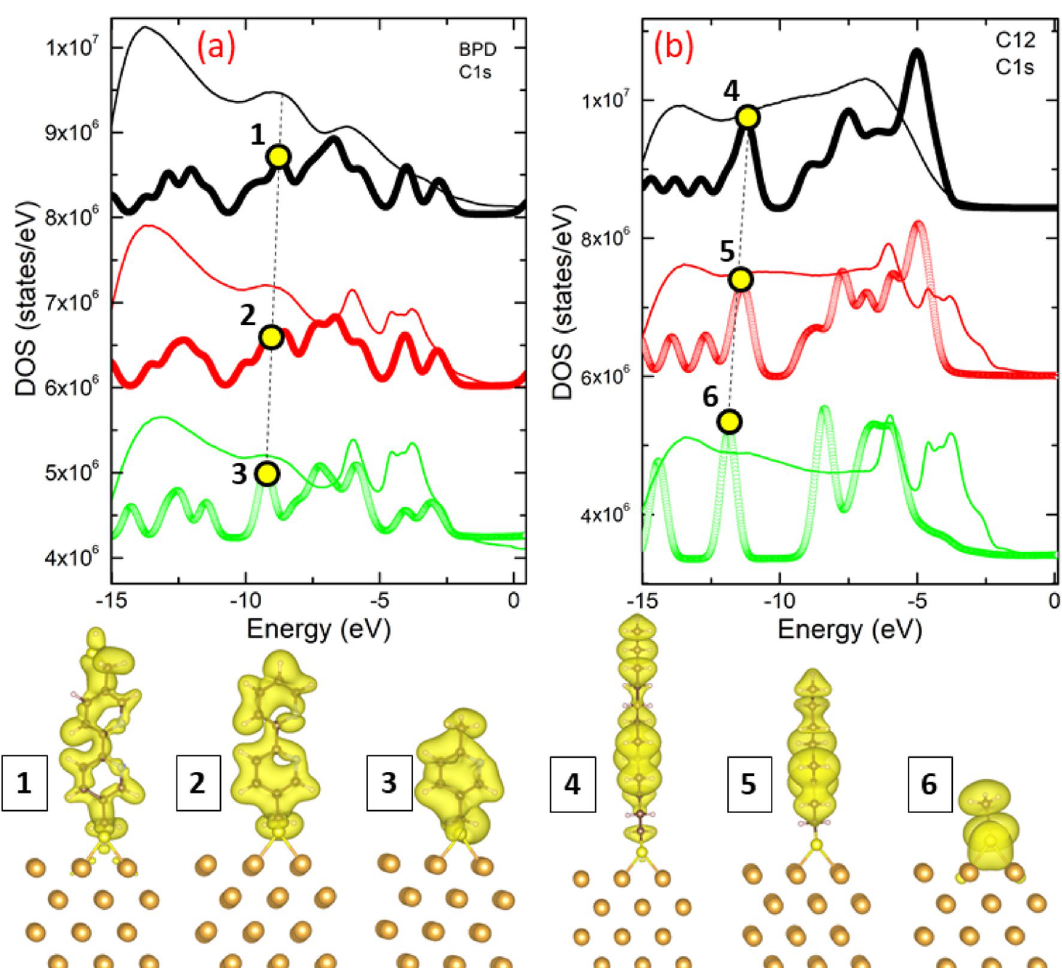
Figure 6. Calculated DOS (thick curves) of ( a ) BPD derivatives (panels 1–3) and ( b ) C12 derivatives (panels 4–6) as a function of energy normalized to Fermi energy. Thin curves show the experimental UPS spectra at different etching times. Panels 1–6 show the isosurface plots of electron eigenstates at electron energies indicated on the DOS curves. Panels 1–3 in this figure are the model systems presented by panels 7, 9 and 10 in Fig. 5. Panels 4–6 in this figure correspond to panels 1, 3 and 6 in Fig. 5, but viewed from different